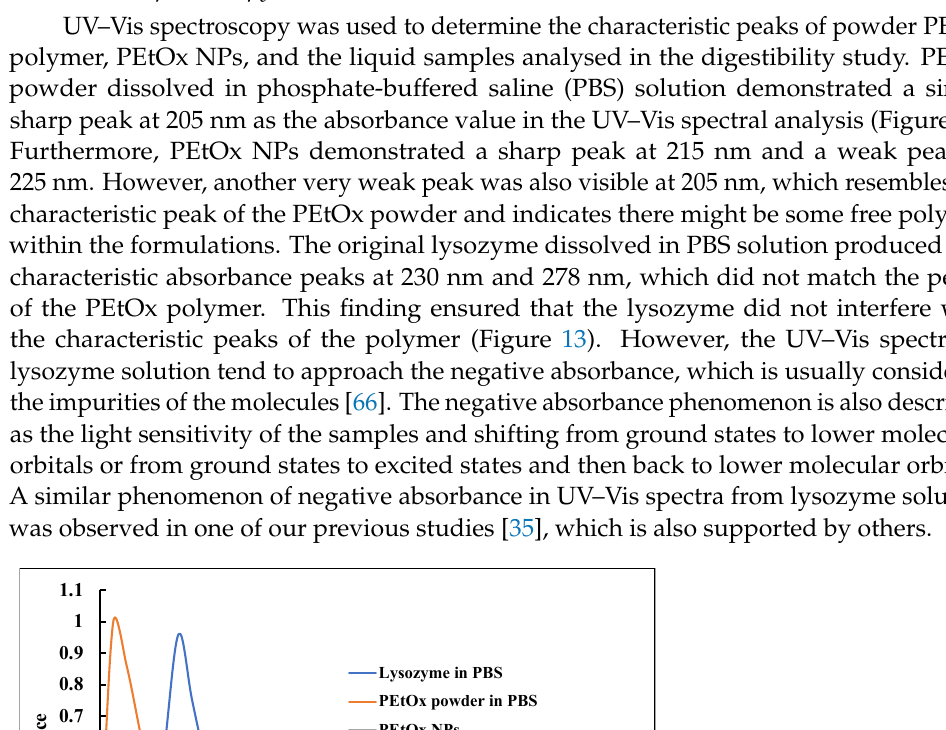
Figure 12. SEM photomicrographs of PEtOx NPs before and after incubating in SLF at different time intervals ( A ) PEtOx original NPs ( B ) PEtOx NPs 1 week ( C ) PEtOx NPs 2 weeks ( D ) PEtOx NPs 3 weeks ( E ) PEtOx NPs 4 weeks ( F ) PEtOx NPs 5 weeks ( G ) PEtOx NPs 6 weeks.